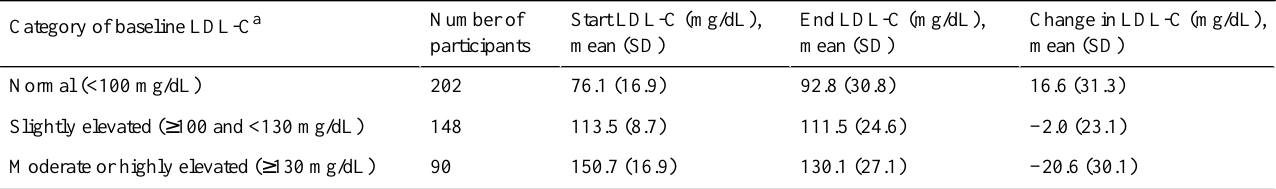
Table 4. Changes in low-density lipoprotein cholesterol (LDL-C) levels according to the category of baseline LDL-C.